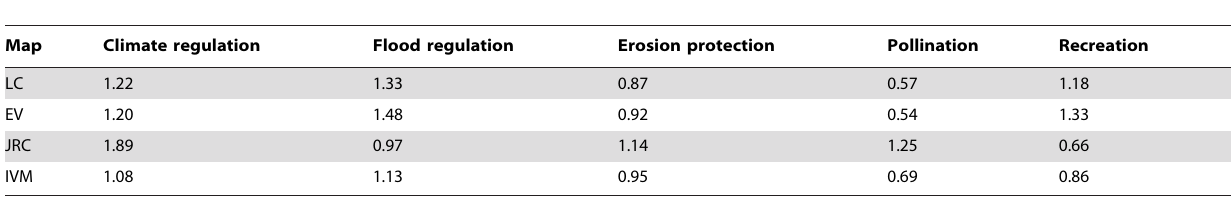
Table 5. Agreement between ecosystem service maps and independent maps.